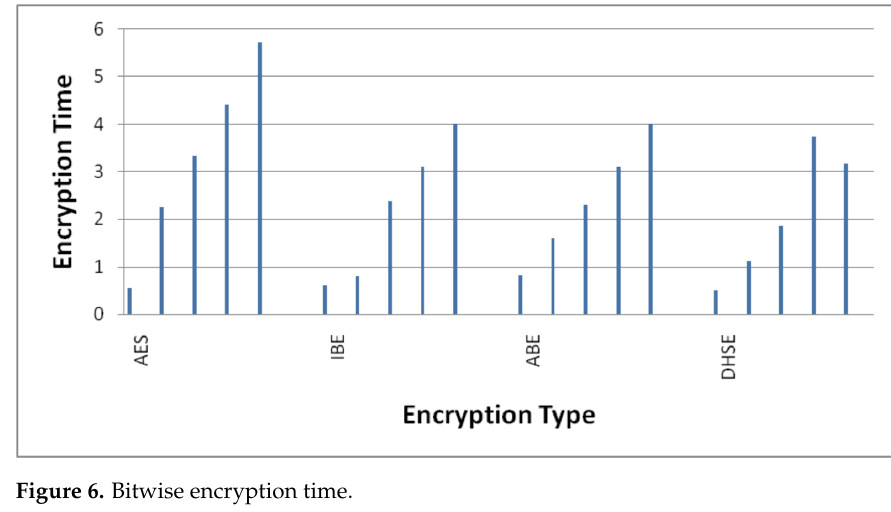
Figure 6. Bitwise encryption time.